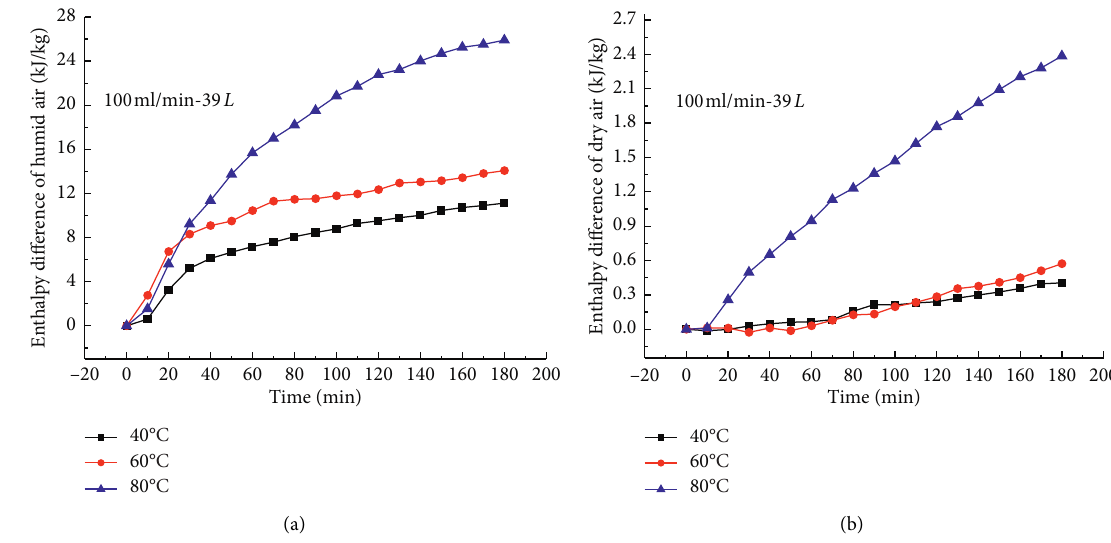
Figure 12: Curves of enthalpy difference variations at different temperatures under the condition of